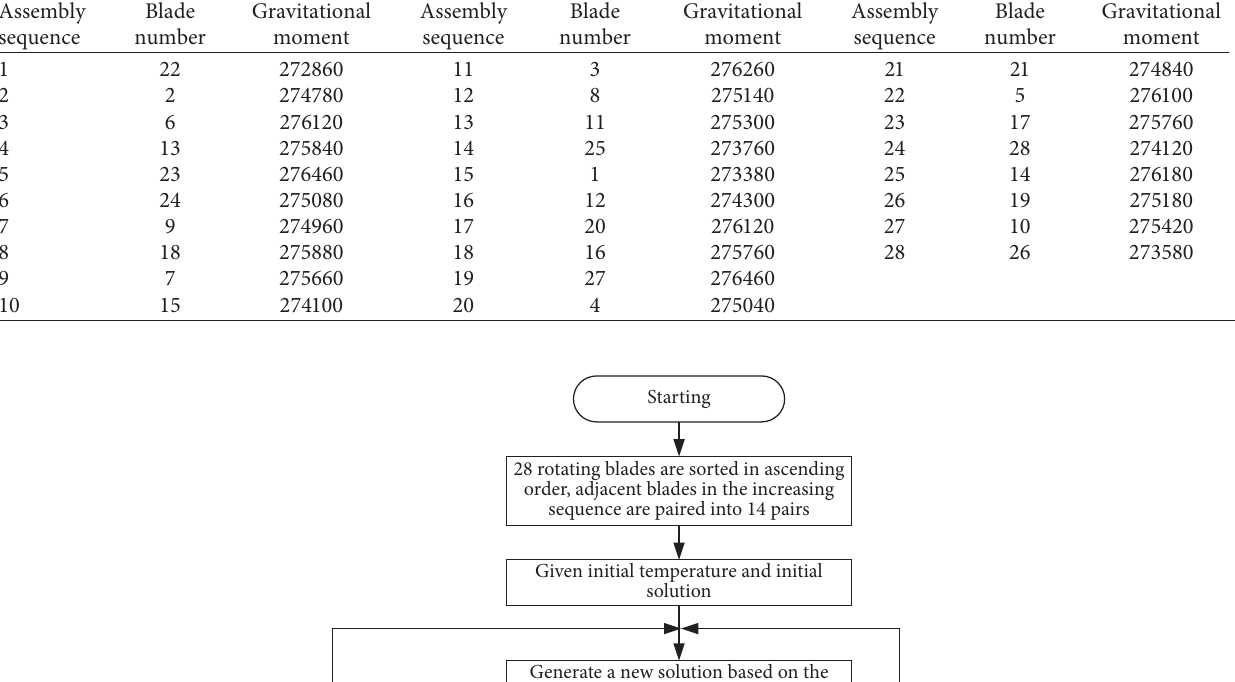
Table 7: The assembly sequence planned by simulated annealing algorithm (gravitational moment: g ∗ mm).